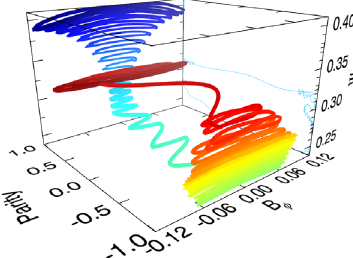
Fig. 10. 3D phase portrait between parity, toroidal magnetic fi eld and shear proxy from solution 4 taken at the same time span as Figure 9 and extracted at 0.85R radius and 15 (cid:3) latitude. The color encodes the advance of time from blue to